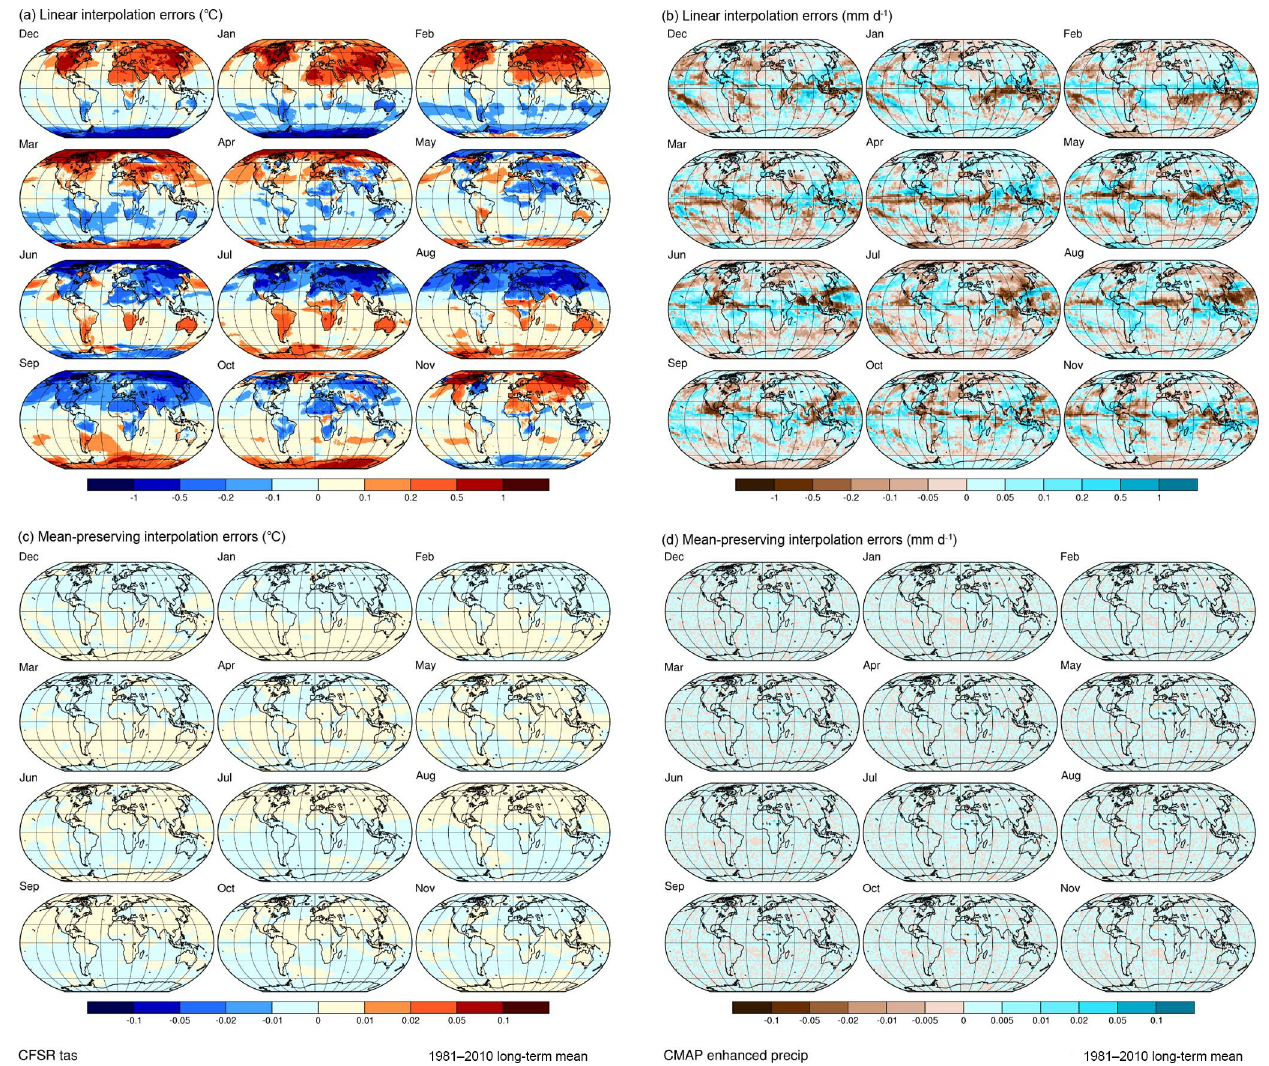
Figure 16. Pseudo-daily interpolation errors for CFSR near-surface air temperature (a, c) and CMAP precipitation rate (b, d) . (a, b) The interpolation errors, or the differences between the original monthly mean values and the monthly mean values recalculated from linear interpolation of pseudo-daily values. (c, d) The interpolation errors for mean-preserving (Epstein, 1991) interpolation. The errors for linear interpolation of the temperature data ( ◦ C) range from − 1 . 20851 to 1.29904, with a mean of 0.05664 and standard deviation of 0.16129 (over all months and grid points), while those for mean-preserving interpolation range from − 0 . 00002 to 0.00050, with a mean of − 0 . 0061 and standard deviation of 0.00007. The errors for linear interpolation of the precipitation data (mmd − 1 ) range from − 1 . 10617 to 1.40968, with a mean of 0.00087 and standard deviation of 0.11851, while those for mean-preserving interpolation range from − 0 . 00002 to 0.00383, with a mean of 0.00001 and standard deviation of